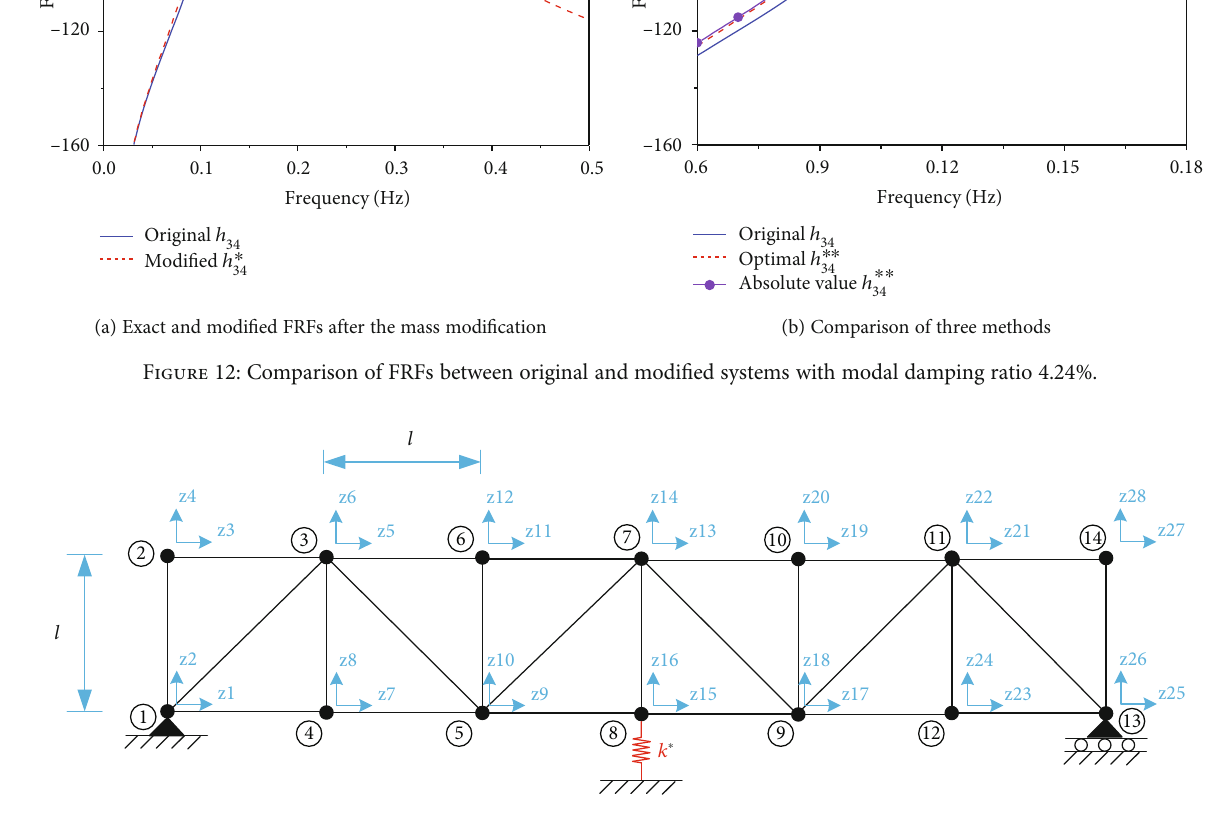
Figure 13: Planar truss system.